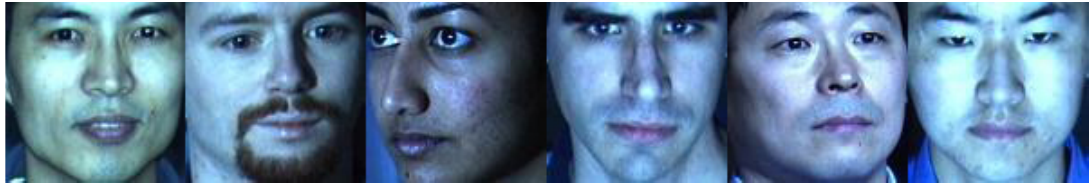
Figure 16. Sample images from the CMU-PIE face image database.